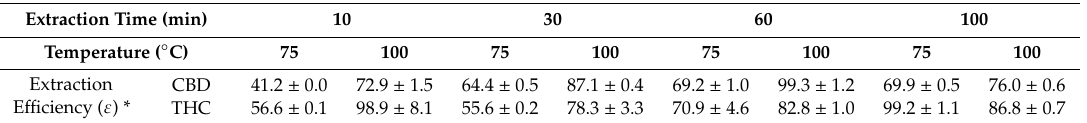
Table 6. Extraction e ffi ciency of the PLE experiments performed in the 1 L autoclave with hemp variety Finola (Section 2.5, Table